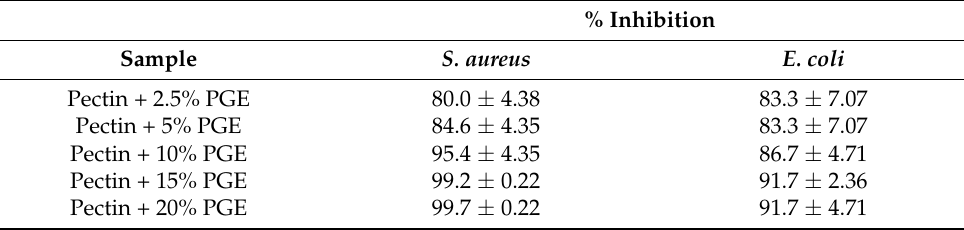
Table 3. Inhibition of E. coli and S. aureus bacteria by Pectin/PGE emulsion with different PGE loadings.